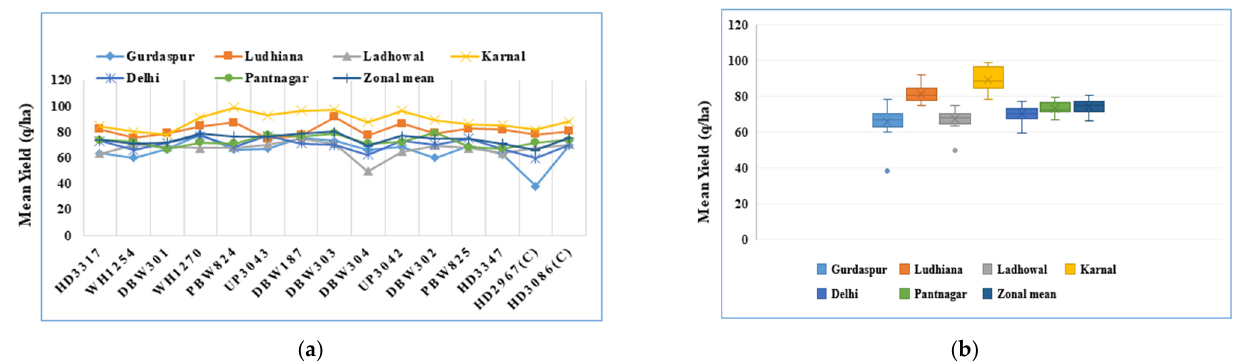
Figure 1. Graphical representation of mean yield of 15 varieties and 6 environments. ( a ) line graph illustrates varietal performance; ( b ) box plot illustrates environment-wise performance.